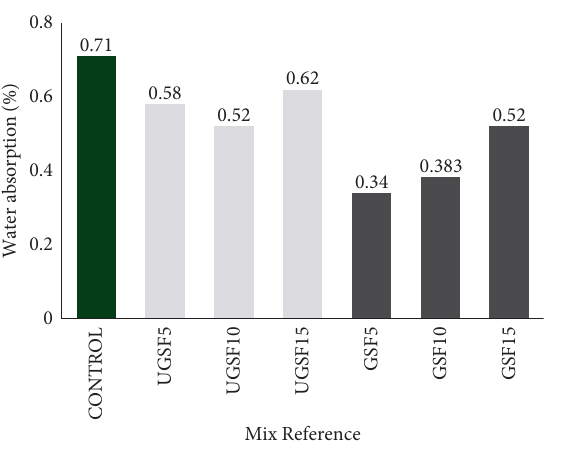
Figure 12: Water absorption values of SF. Table 5: Sorption coefficient.